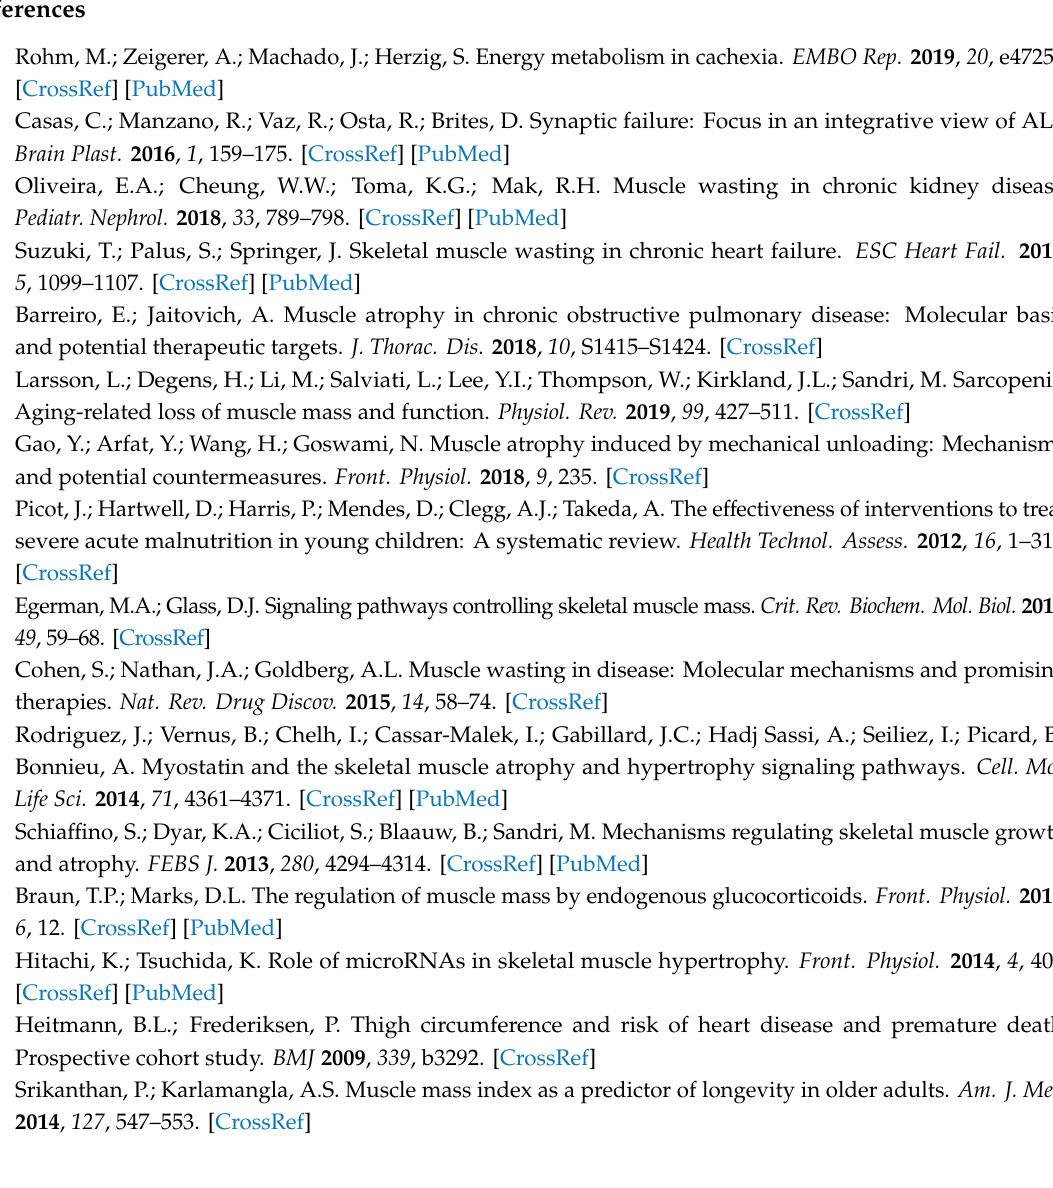
s1. Supplementary Table S1: The raw data of qRT-PCR. Figure S1: Changes in the expression of skeletal muscle di ff erentiation-related lncRNAs in six muscle atrophy conditions. Figure S2: Changes in the expression levels of skeletal muscle di ff erentiation-related lncRNAs in skeletal muscle hypertrophy